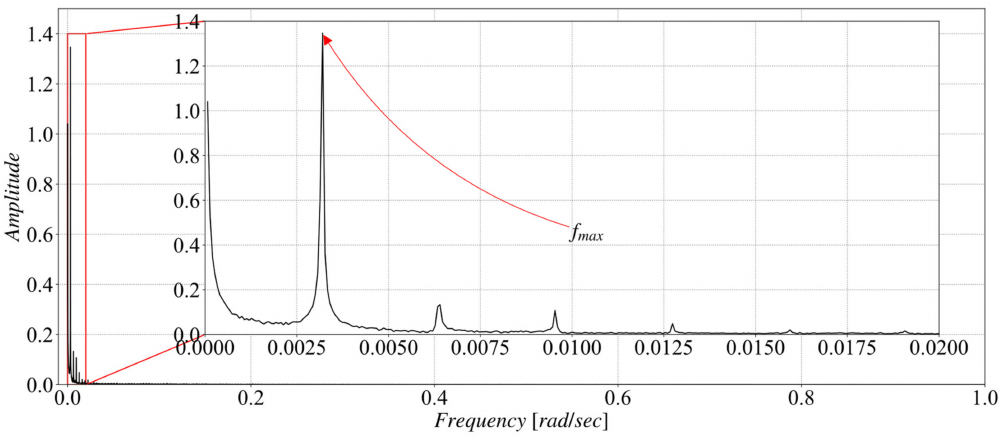
Figure 4. Fast Fourier transform of a sample data to obtain f max